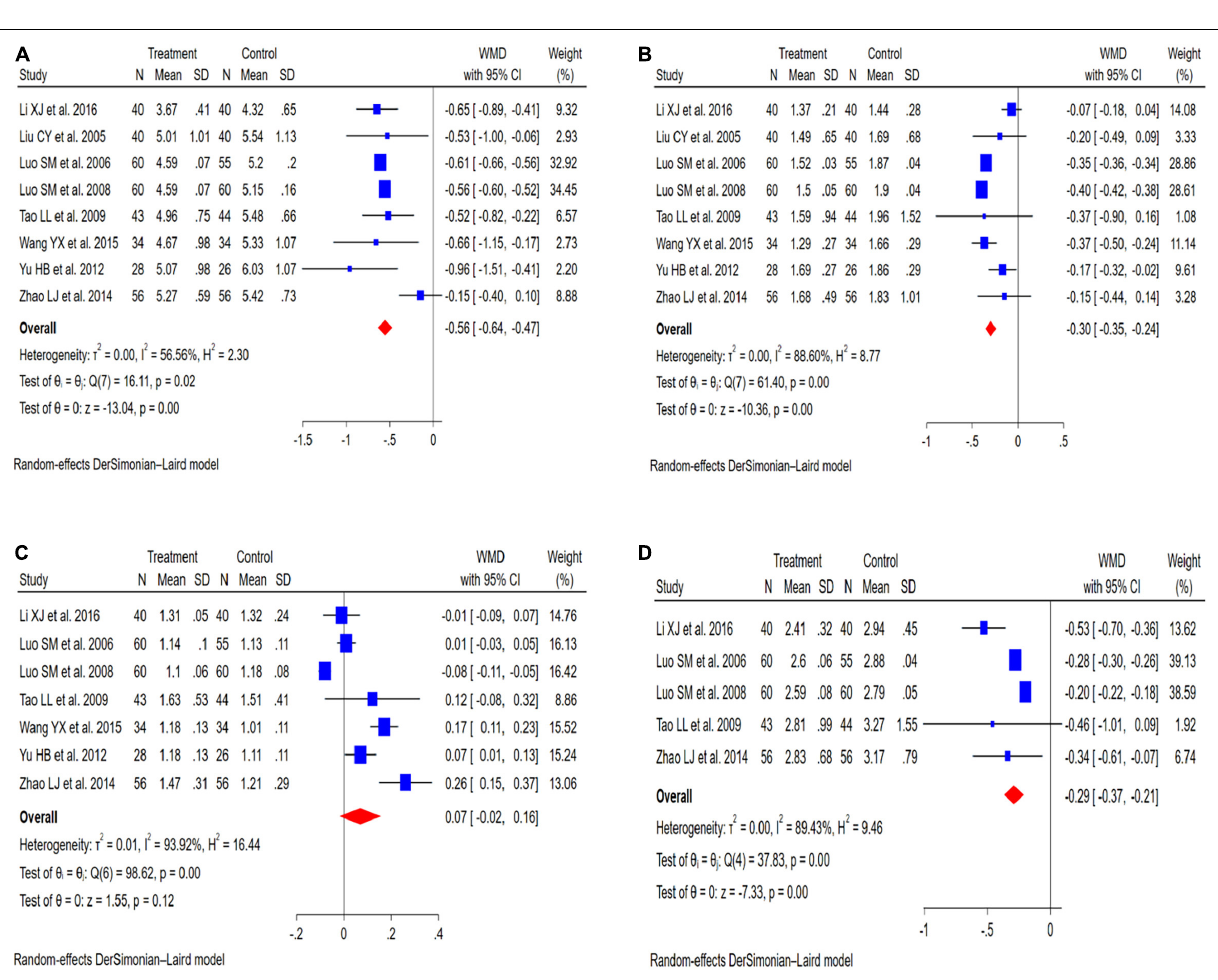
on HDL-C levels (WMD: 0.07 mmol/L; 95% CI: − 0.02, 0.16; I 2 = 93.92%; P = 0.12). The results of sensitivity analysis were